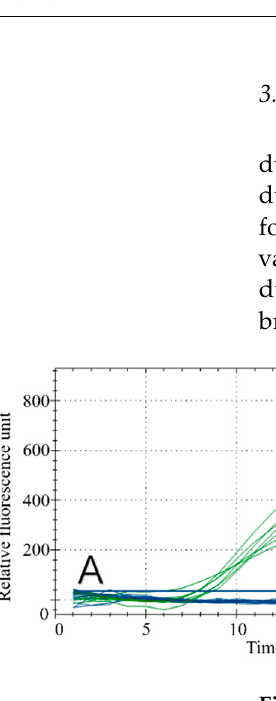
Figure 8. RPA detection results in mixed adulteration ratio for beef–duck ( A ), mutton–duck ( B ), beef–duck ( C ) and mutton–duck ( D ).